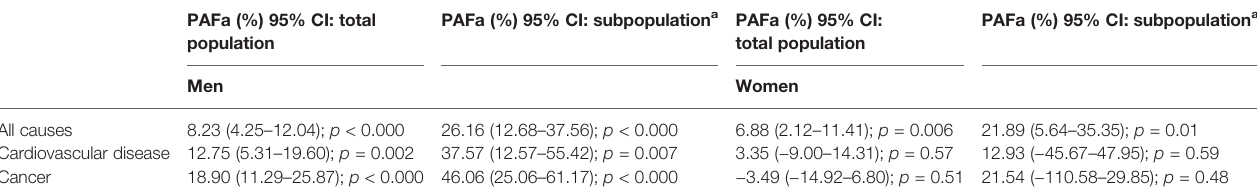
TABLE 4 | Sex-speci fi c PAFs of sarcopenia to all-cause and cause-speci fi c mortality in the US population.